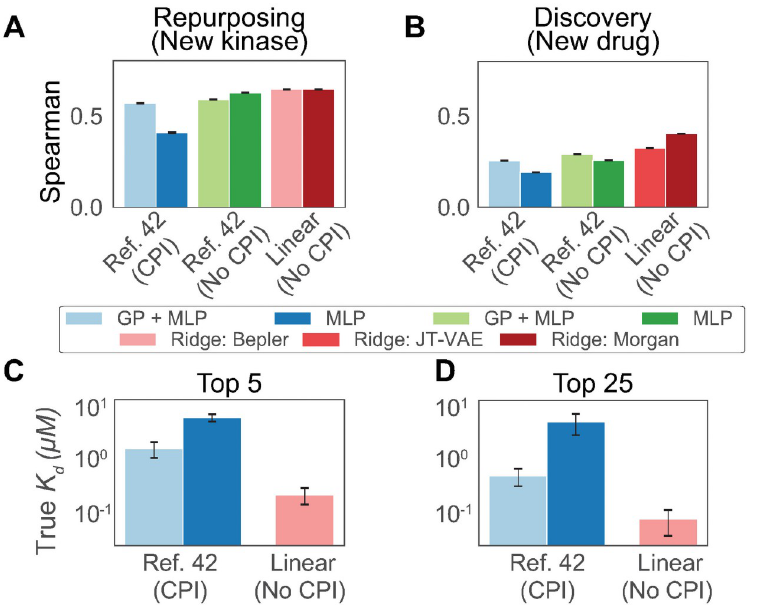
Fig 4. Evaluating single-task models on kinase repurposing and discovery tasks. Kinase data from Davis et al. is extracted, featurized, and split as prepared in Hie et al. Multilayer perceptrons (MLP) and Gaussian process + multilayer perceptron (GP+MLP) models are employed. We add variants of these models without CPI training separate single-task models for each enzyme and substrate in the training set, as well as linear models using both pretrained featurizations (“Ridge: JT-VAE”) and fingerprint based featurizations of small molecules (“Ridge: Morgan”). Spearman correlation is shown for (A) held out kinases not in the training set and (B) held out small molecules not in the training set across 5 random initializations. (C) We repeat the retrospective evaluation of lead prioritization. The top 5 average acquired K values are shown for the CPI models in Hie et al. compared against a d linear, single-task ridge regression model using the same features. (D) The top 25 average acquired K d values are shown.